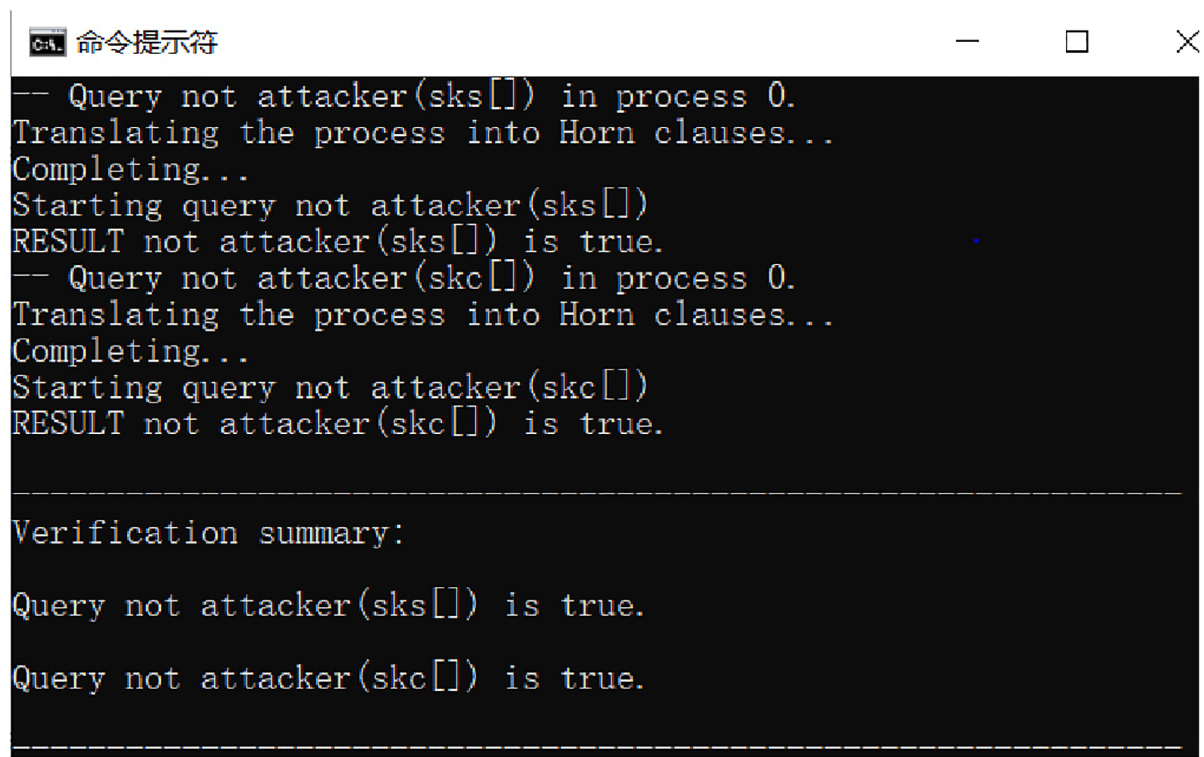
Fig 19. Privacy analysis result.